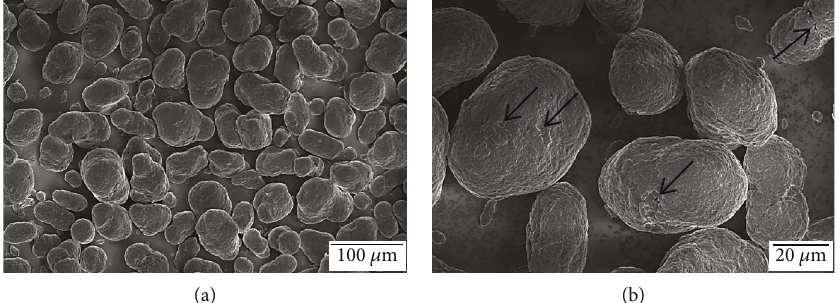
Figure 1: SEM images of PA powder. (a) An overview and (b) detailed view of the surface morphology (arrows reveal micron-sized voids within particle).